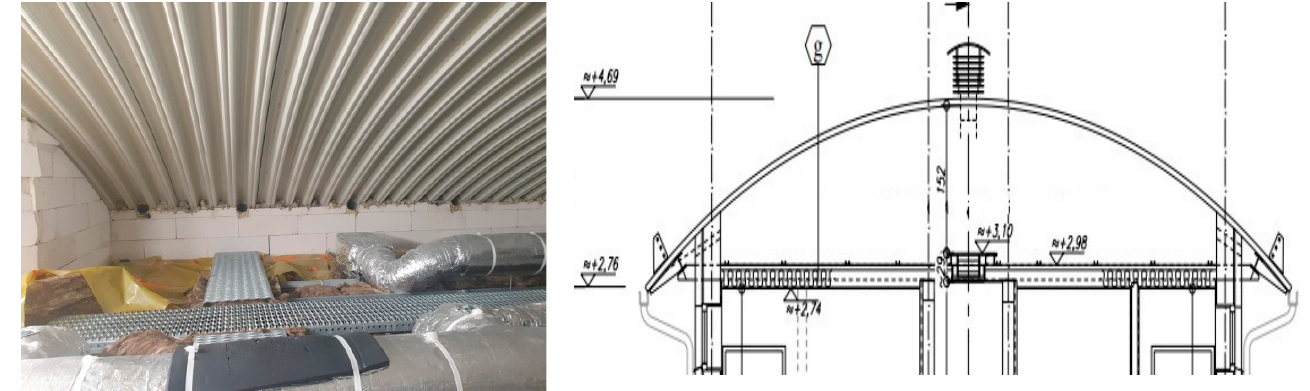
Figure 2. Geometrically complicated roof space in a ventilated roof (analysed here).